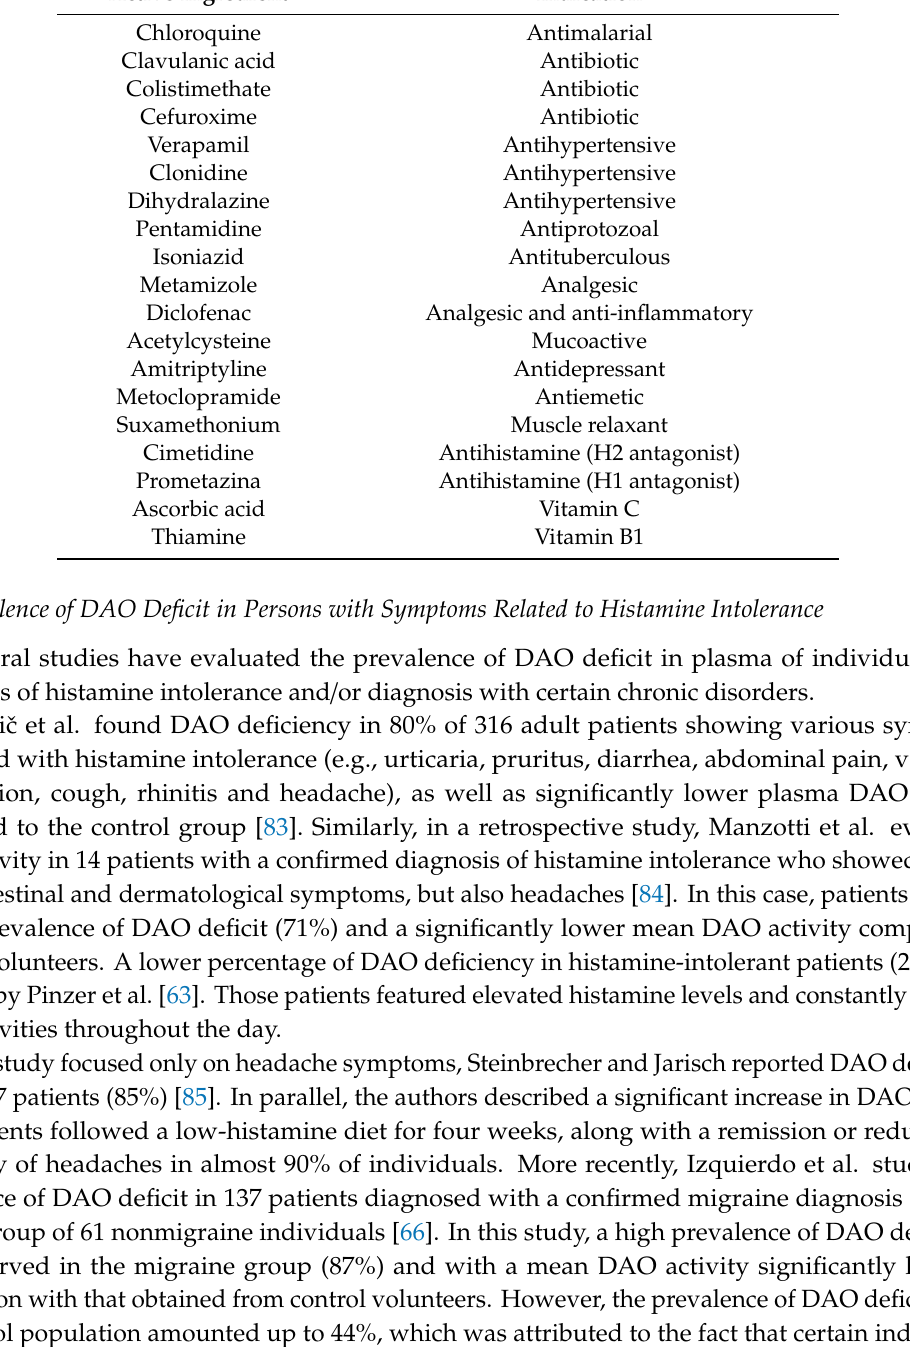
Table 2. Active ingredients with an experimentally demonstrated inhibitory e ff ect on the DAO enzyme [23,28,80,81]. Active Ingredient Indication Chloroquine Antimalarial Clavulanic acid Antibiotic Colistimethate Antibiotic Cefuroxime Antibiotic Verapamil Antihypertensive Clonidine Antihypertensive Dihydralazine Antihypertensive Pentamidine Antiprotozoal Isoniazid Antituberculous Metamizole Analgesic Diclofenac Analgesic and anti-inflammatory Acetylcysteine Mucoactive Antiemetic Muscle relaxant Antihistamine (H2 antagonist) Antihistamine (H1 antagonist) Ascorbic acid Vitamin C Vitamin